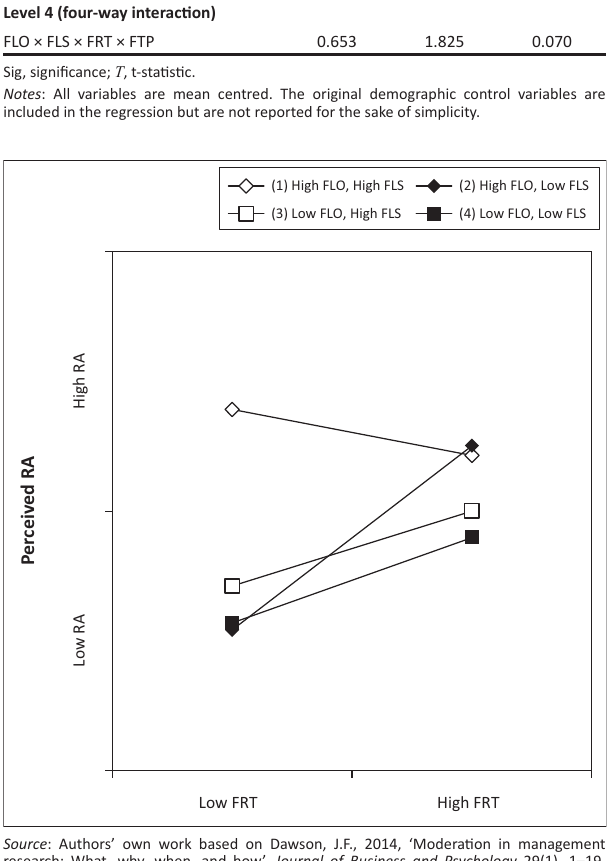
FIGURE 1: Moderating effects of financial literacy on risk tolerance (three-way The significant three-way interaction term indicates that the relationship between one of the variables and perceived RA is dependent on two other variables; however, the precise relationship cannot be specified; therefore post hoc analysis was carried out to determine the nature of the relationship by plotting slopes and carrying out slope difference tests (Dawson 2014; Dawson & Richter 2006).